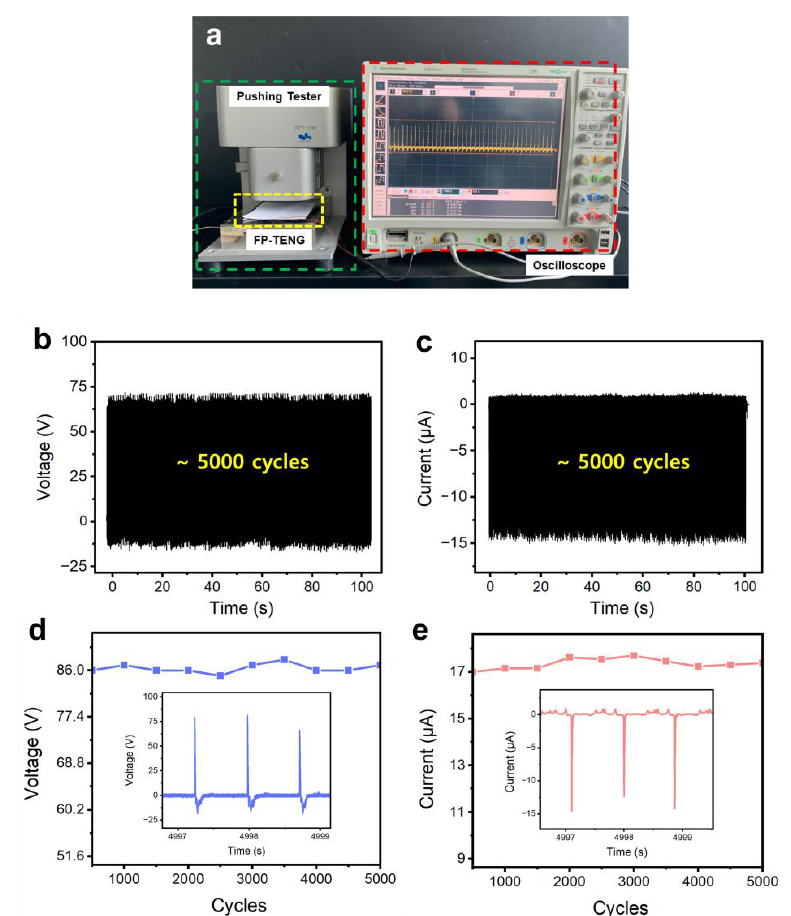
Figure 4. ( a ) Photograph of the test setup using a pushing tester. ( b , c ) Output voltage and